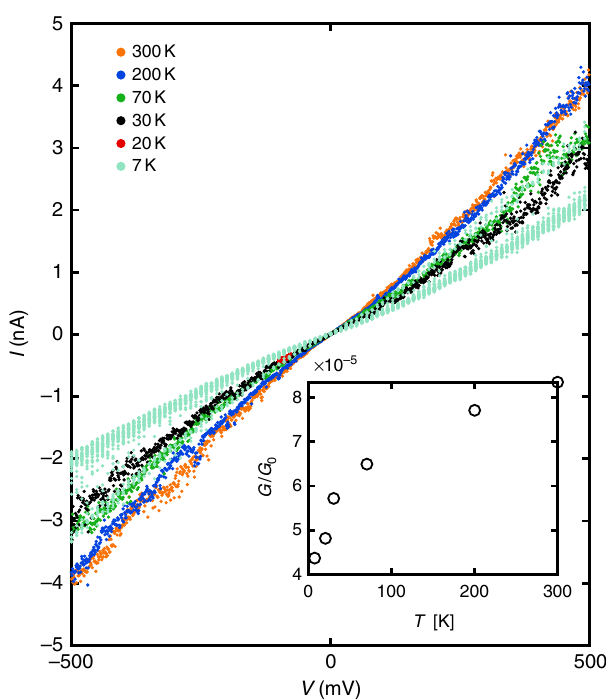
Fig. 6 Temperature dependent I – V characteristics of a molecular junction. The I – V characteristics of an OPE3 junction in vacuum reveals the suitability and stability of molecular junctions formed using CDBJ for experiments from 300 K down to cryogenic temperatures. The low bias conductance ( G ) of the molecular junction decreases with decreasing temperature (inset)